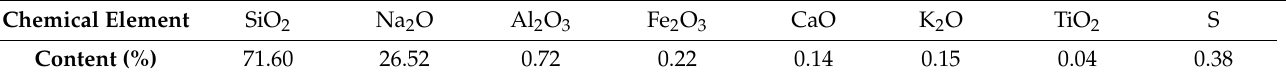
Table 3. Chemical Composition of Water Glass.